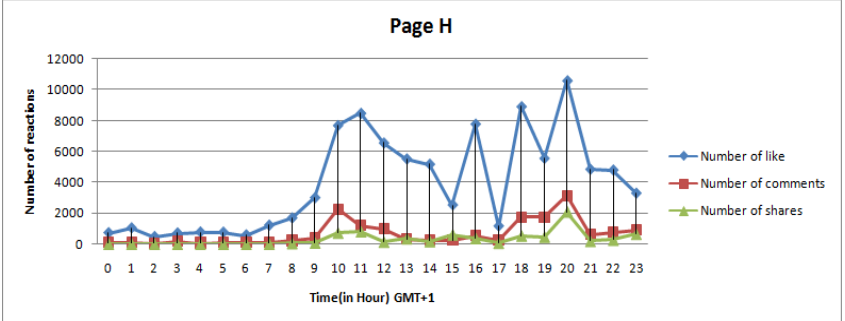
Fig. 7. Number of interactions per publishing hour for page H with 82 posts